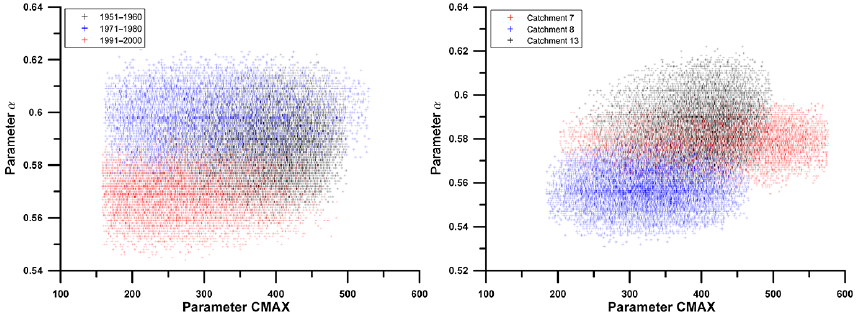
Figure 5. Scatterplots for two selected HYMOD parameters (CMAX and α ) obtained via model calibration using NS as performance measures. Left panel: for catchment 13 (black: 1951–1960, blue: 1971–1980, and red: 1991–2000); Right panel: for catchments 7 (red), 8 (blue), and 13 (black) for